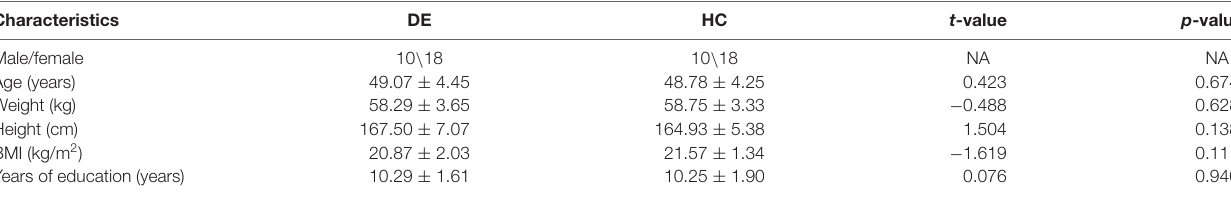
TABLE 1 | Clinical characteristics of patients between DE and HC group.